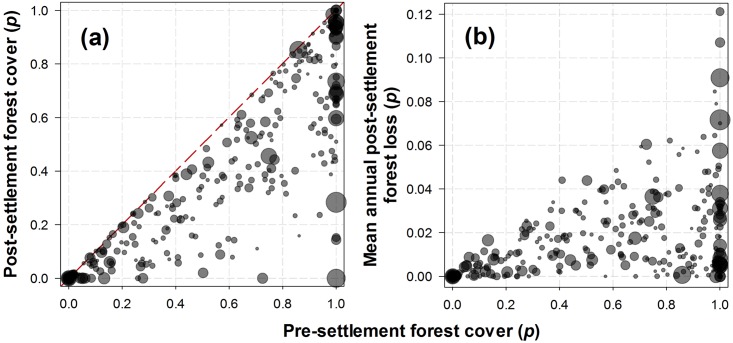
Proportion of forest cover and human population density.Pre- and post-settlement (a) forest cover and (b) mean post-settlement deforestation rates within agrarian reform settlement areas across the Brazilian Amazonia. Circle size represents the landscape-scale human population density (log10 households km-2) within a 10-km buffer area outside settlements.